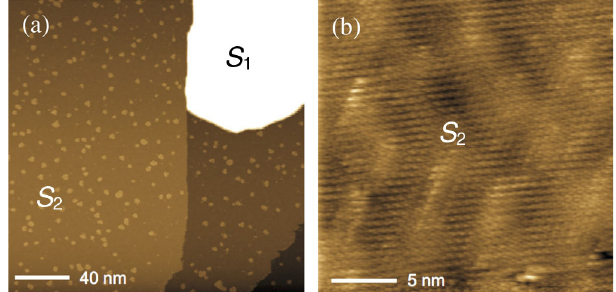
FIG. 1. (a) Topographical STM image of a 7-ML-high Pb island, denoted as S 1 , surrounded by the SIC Pb monolayer, denoted as S 2 . Small Pb clusters of few-nanometers size and 1- ML height are visible on the SIC monolayer. These very small clusters result from the extra Pb atoms deposited on the surface in order to form few large islands such as S 1 . (b) Topographical STM image showing a smaller-scale region representing the atomic superstructure of the SIC monolayer observed everywhere on the surface between the Pb clusters. The images were taken at − 1 . 0 V and I ¼ 35 V bias ¼